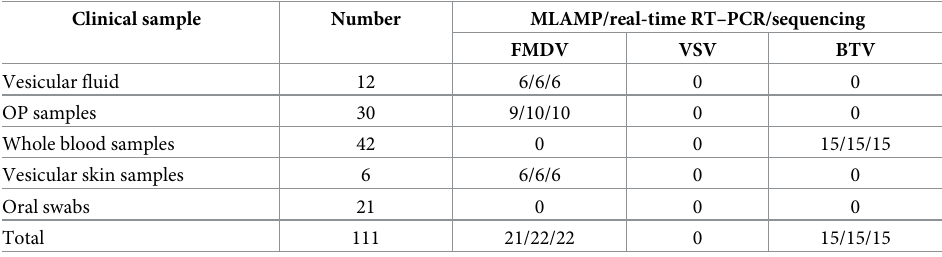
Comparison of mLAMP and real-time RT–PCR assays in clinical detection To assess the applicability of mLAMP for the detection of viral RNA in the field, we compared this method with real-time RT–PCR for 111 clinical specimens, and the detection results are shown in Table 4. The positive real-time RT–PCR products were sent to the BGI (Beijing Genomics Institute, China) for DNA sequence confirmation with real-time RT–PCR primers. The sequencing results showed that all the positive results were true positives. The sensitivity and specificity of mLAMP for the detection of BTV were 100% (15/15) and 100% (96/96), respectively, compared to those of the real-time RT–PCR assay. However, in the detection of FMDV, 21 samples were positive by mLAMP, and 22 samples were positive by real-time RT– PCR. One discrepant sample was found, which was positive for FMDV by real-time RT–PCR but negative by mLAMP. The sequencing results also indicated that the discrepant sample was a true FMDV-positive sample. The sensitivity and specificity of mLAMP for the detection of FMDV were thus 95.5% (21/22) and 100% (89/89), respectively. Since VSV has not been found in China thus far, no VSV-positive samples were detected in this test. No coinfected positive samples were detected in this test. Although no VSV-positive samples were detected due to the geographical limitations of sampling, the results for VSV were consistent with those obtained by real-time RT–PCR. The mLAMP results exhibited 99.1% agreement (kappa coefficient, Table 4. Performance of the mLAMP assay for detection in clinical